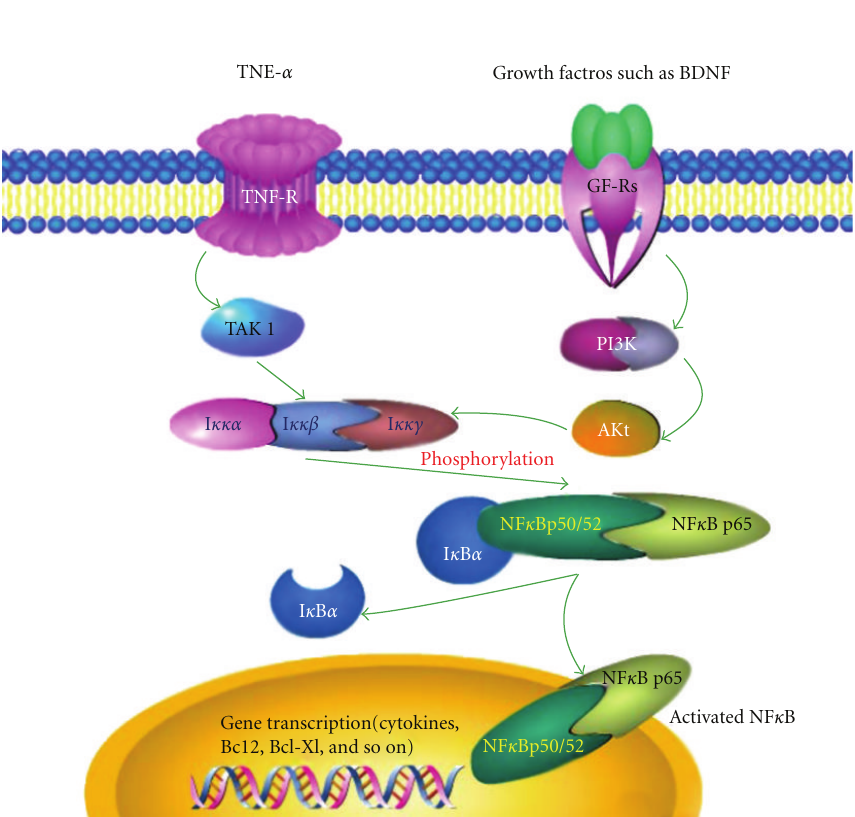
Figure 6: NF- κ B signal transduction pathway. NF- κ B heterodimer between p65 and p50/52 proteins is located in the cytosol complexed with the inhibitory protein I κ B α . Through the intermediacy of integral membrane receptors, a variety of extracellular signals (like TNF α or growth factor BDNF) can activate the enzyme I κ B kinase (IKK, consisting of Ikk α , β , and γ ) via TAK1 or PI3K/Akt, respectively. IKK, in turn, phosphorylates the I κ B α protein, which results in dissociation of I κ B α from NF- κ B and eventual degradation by the proteosome. The activated NF- κ B is then translocated into the nucleus where it binds to specific sequences of DNA called response elements and initiates the gene